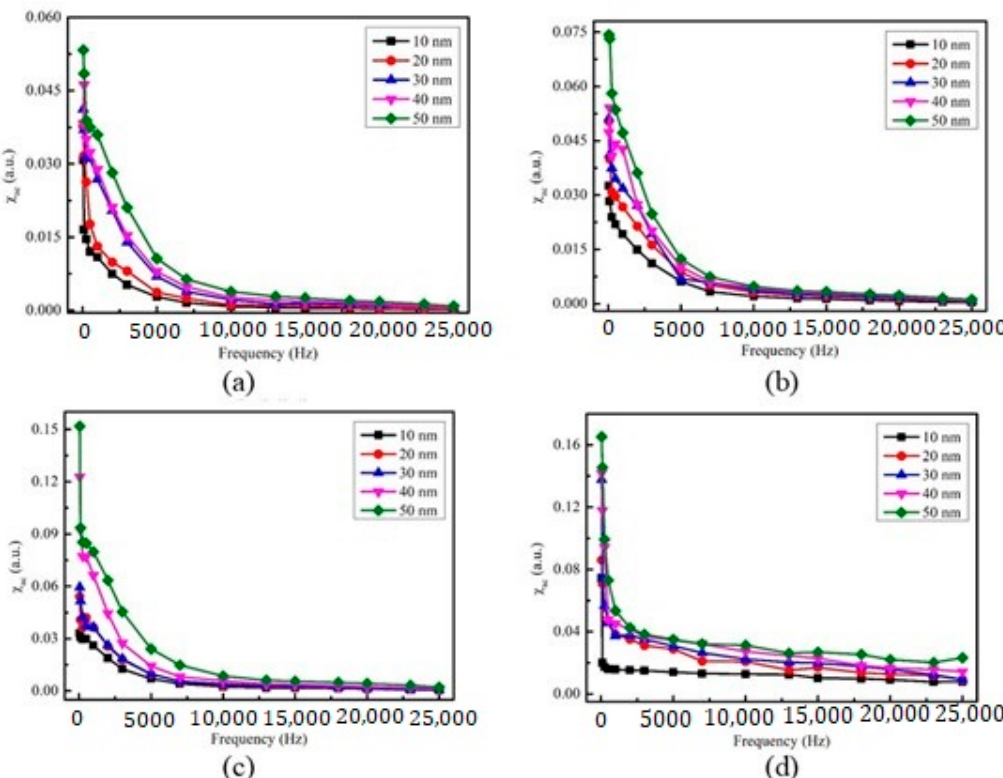
Figure 5. The low-frequency alternate-current magnetic susceptibility ( χ ac ) as a function of the frequency from 10 to 25,000 Hz. ( a ) RT, ( b ) after annealing at 100 °C, ( c ) after annealing at 200 °C, ( d ) after annealing at 300 °C.